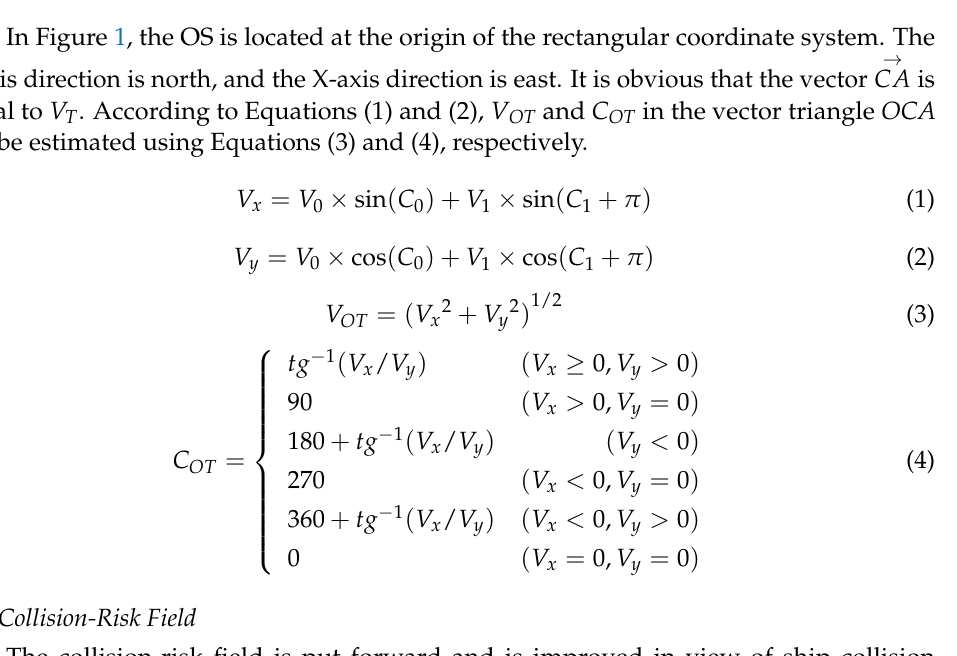
Figure 1. Relative speed and course between own ship and target ship .